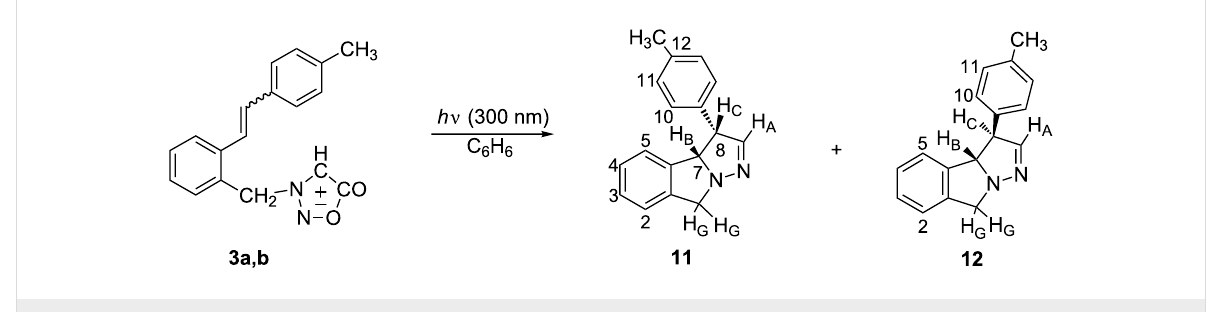
Scheme 3: Photolysis of cis - or trans - 3